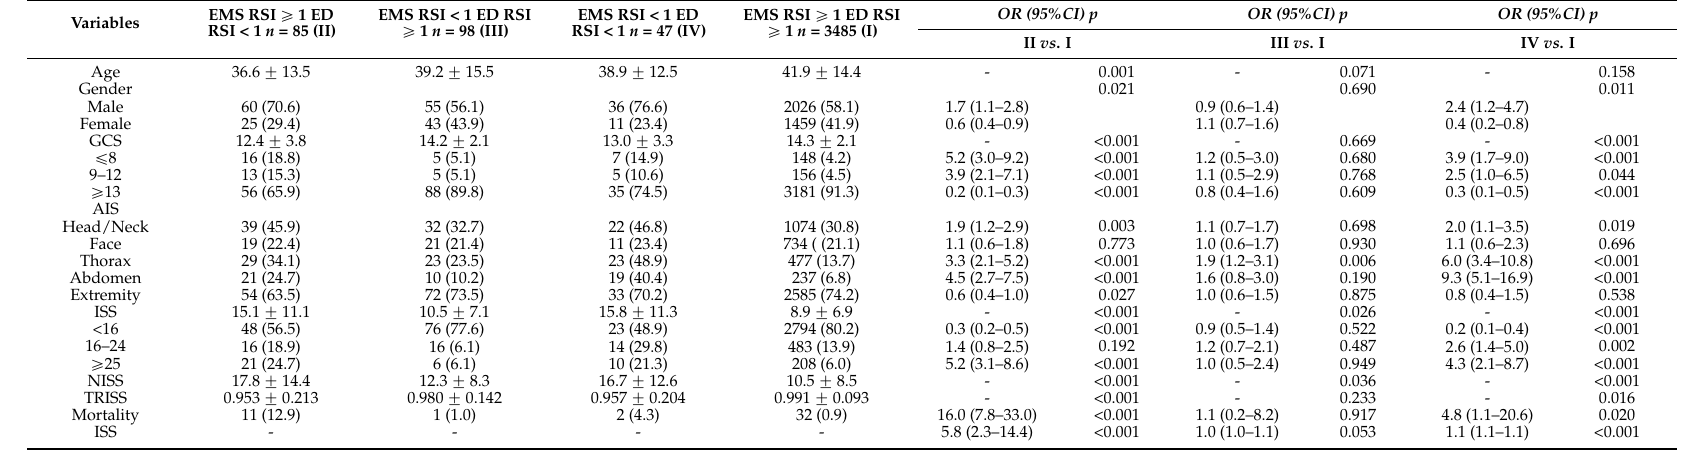
Table 1. Demographic and injury characteristics of hospitalized trauma